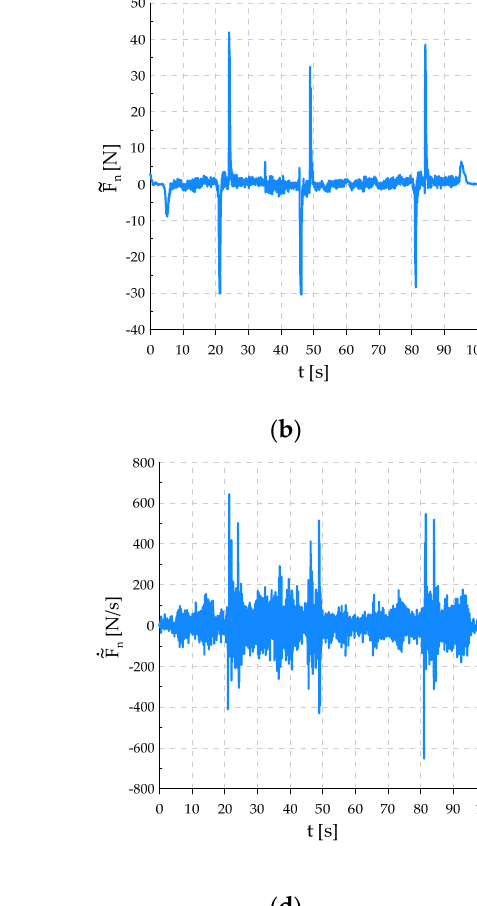
( b ) Figure 12. Control signals: ( a ) PD control signals in tangent directions; ( b ) PD control signal in normal direction.